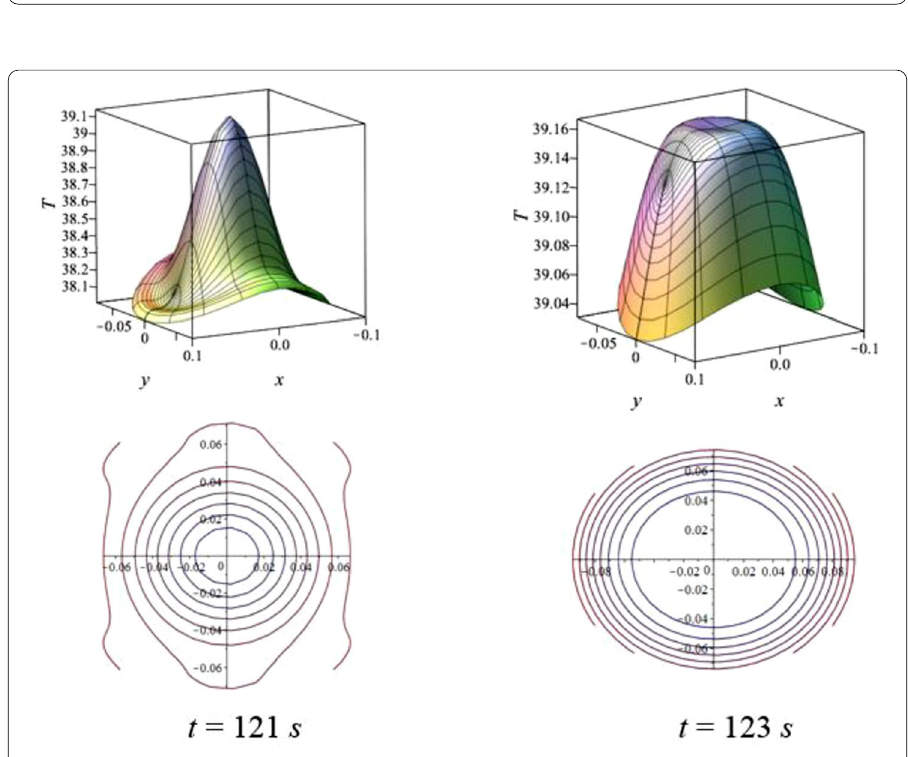
Figure 3 Temperature distribution. Temperature distribution on the cross section z = 1 cm in a full wave cycle at time t = 121 s when dp > 0, and at t = 123 s when dp < 0 for semi-axes lengths of a = 0.1 cm, dz dz b = 0.075 cm and slip length of 0.05